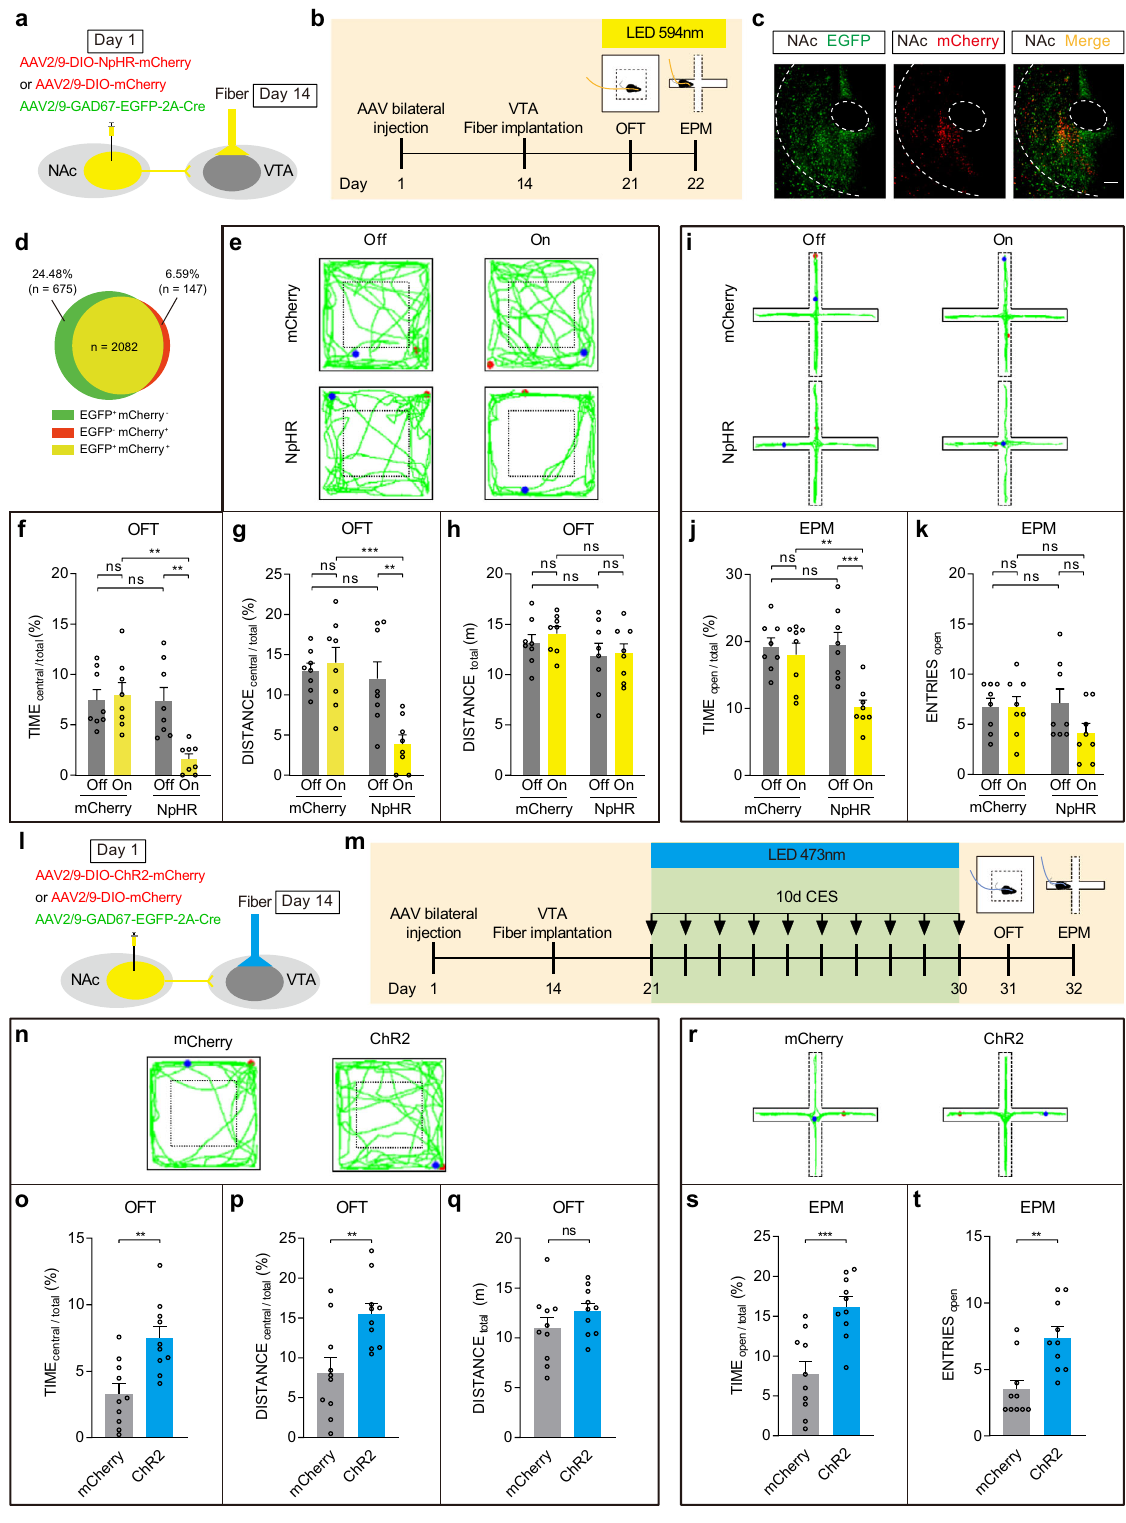
coverslipped with fl uorescent mounting medium and stored at 4 °C before analysis. All images were acquired with an Olympus VS120 microscope. For automated cell counting of fl uorescent protein-positive neurons, the fl uorescence images were analyzed and quantitated by ImageJ Fiji plugins and features. Brie fl y, the red channel and green channel of fl uorescence images were separately segmented by Trainable Weka Segmentation plugin fi rst. The Trainable Weka Segmentation is a Fiji plugin that combines a collection of machine-learning